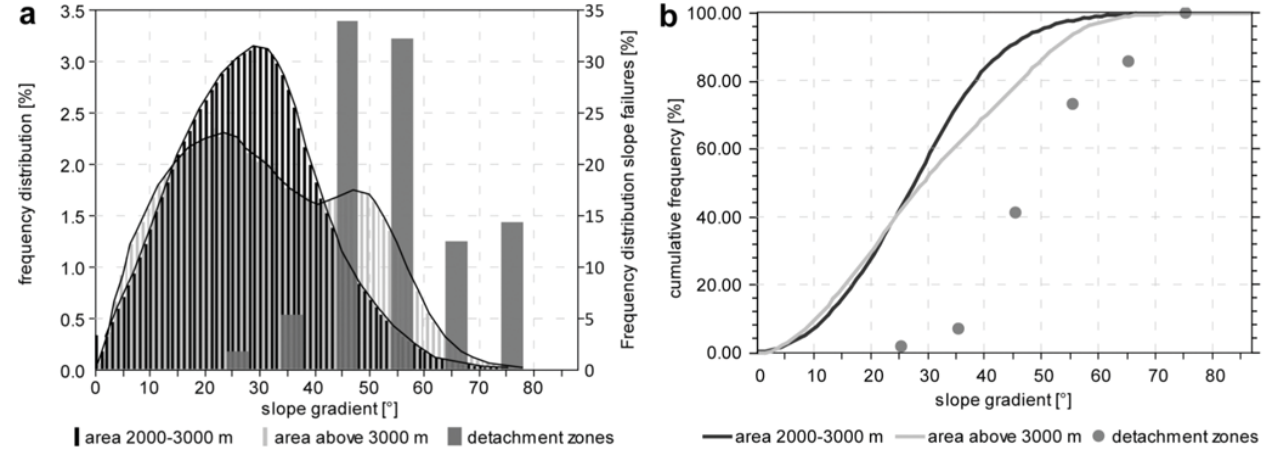
Fig. 7. Frequency distribution of slope gradients for the areas between 2000 and 3000m, the area above 3000ma.s.l., and the slope failure detachment zones (in 10 ◦ intervals; (a) and cumulative frequency of slope gradients for the same data sets (b) .